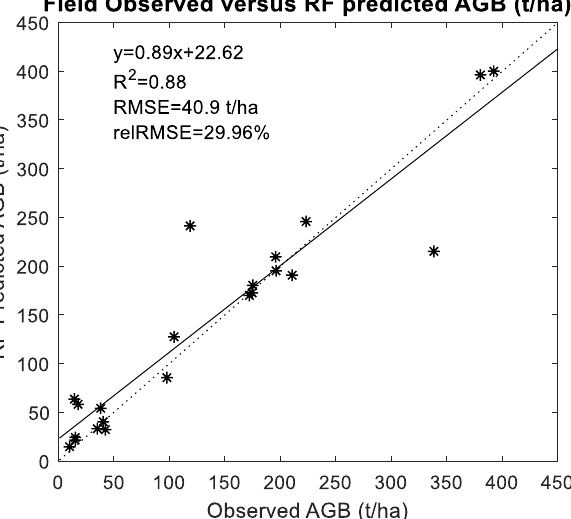
Figure 4. Evaluation of the random forest predicted AGB over the 22 testing forest inventory plots using the six most important predictor variables of %incMSE shown in Figure 2.